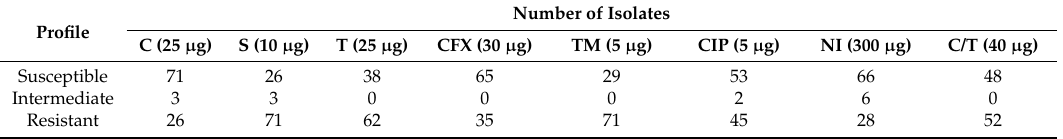
Table 2. Distribution of isolates with respect to resistance to each antibiotic tested *.